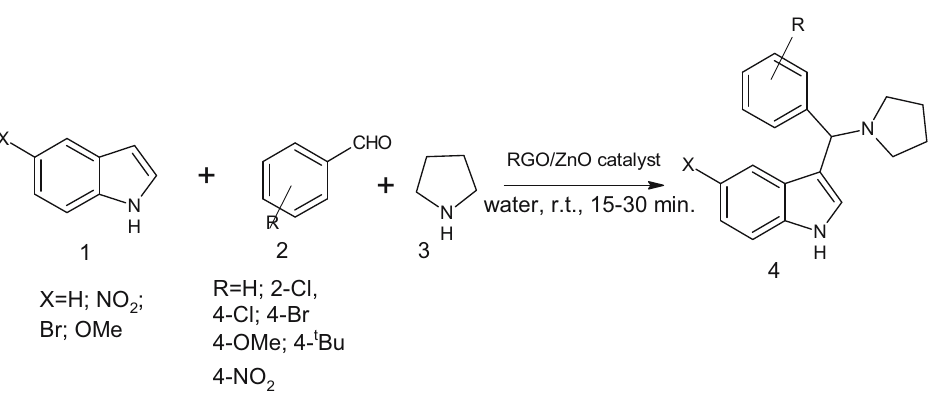
Scheme 8: RGO/ZnO - catalyzed synthesis of 3 - amino alkylated